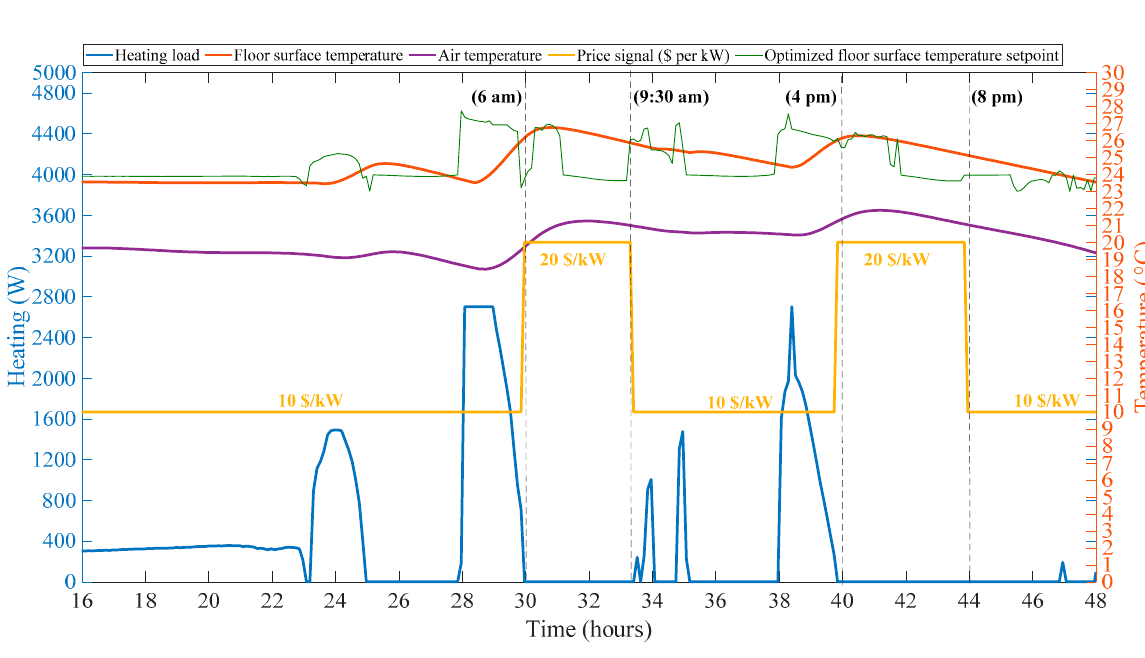
Figure 14. Predictive strategy for price signal #2.